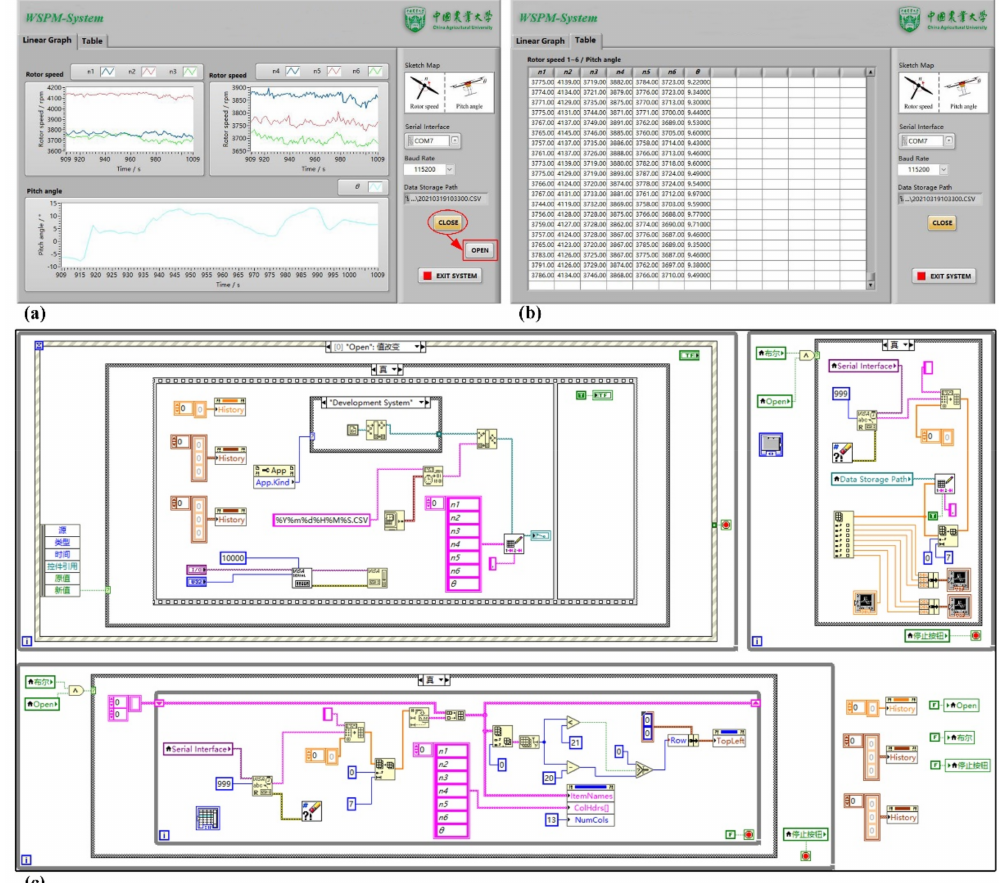
Figure 4. The GUI and program block diagram of the WSPM-System. ( a ) Linear graph on the front panel; ( b ) table on the front panel; ( c ) program block diagram on the rear panel.